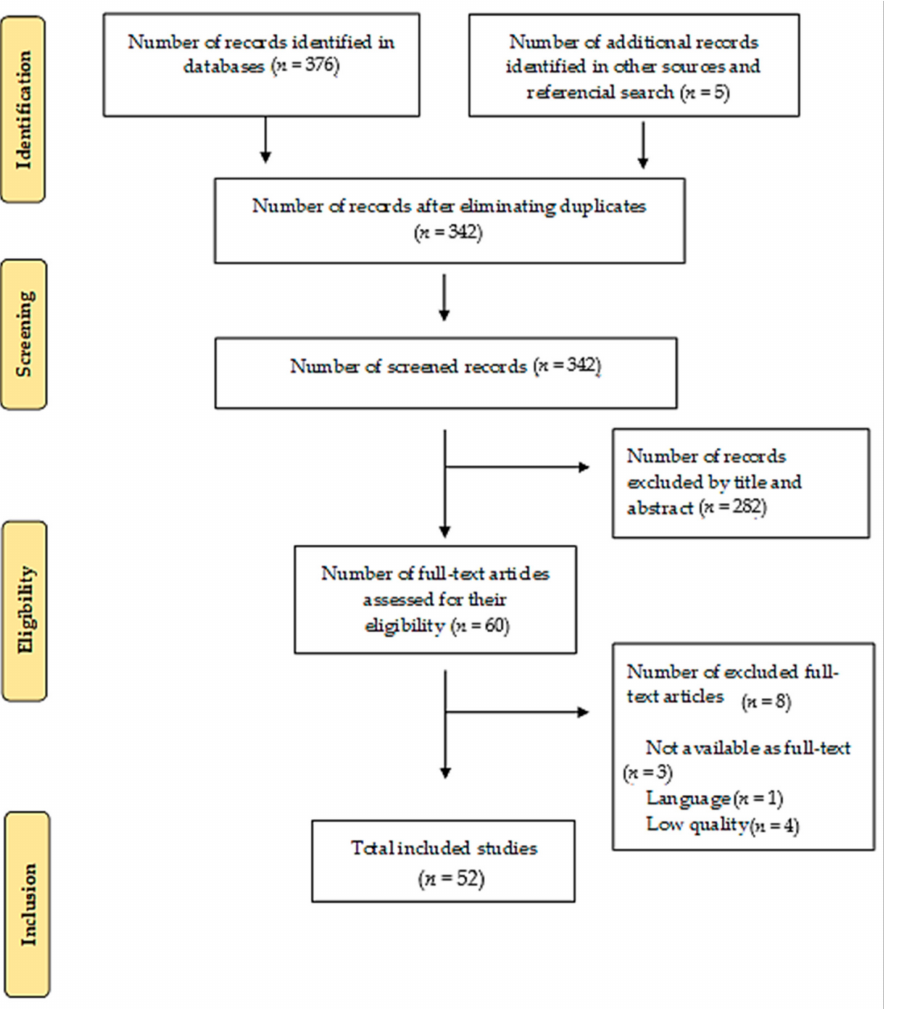
Figure 1. Search results (PRISMA